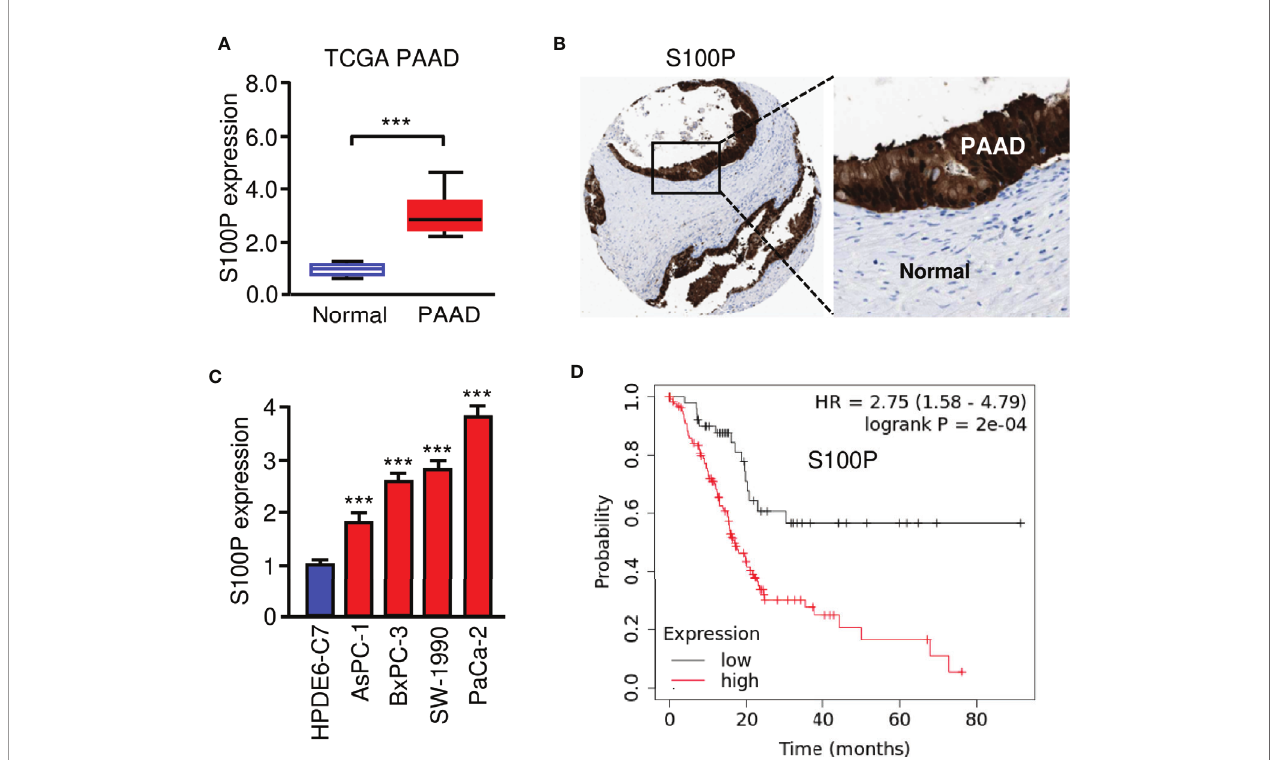
FIGURE 6 | High S100P expression predicts poor prognosis in PAAD. (A) qRT-PCR analysis of S100P mRNA expression in PAAD tissues and adjacent normal tissues. (B) Immunohistochemical data was downloaded from the Human Protein Atlas database. The staining pattern for S100P protein in PAAD tissues and adjacent normal tissues were shown. (C) S100P mRNA expression in PAAD cells and HPDE6-C7 cells. (D) Kaplan-Meier curves for the overall survival of PAAD patients with high or low S100P expression (KM Plotter database). *** P